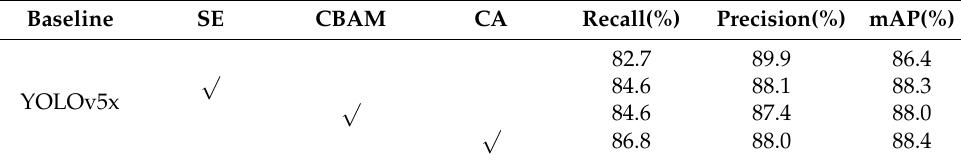
Table 5. Effects of different attention mechanisms on network performance.